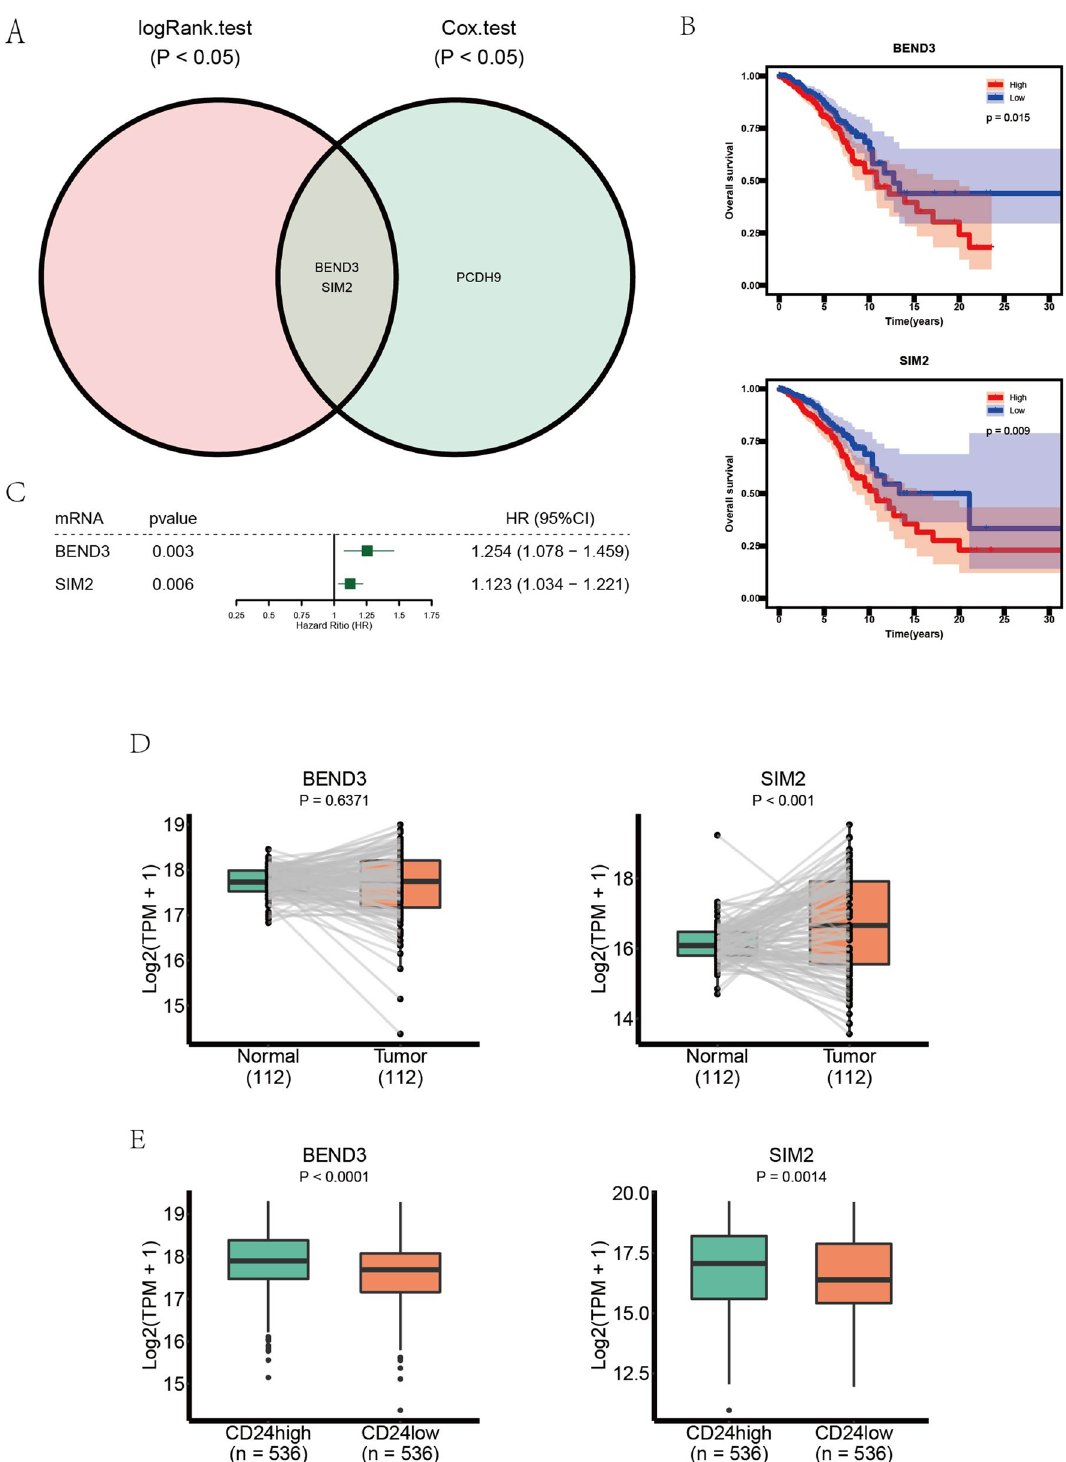
Figure 8. Comprehensive analysis of DEmRNAs. ( A ) Veen diagram of prognosis-related DEmRNAs in CD24- based ceRNA network. ( B ) Kaplan-Meier curve analysis of key DEmRNAs. ( C ) Univariate COX analysis of key DEmRNAs. ( D ) The expression levels of key DEmRNAs in tumor samples and paired adjacent normal samples. ( E ) The expression levels of key DEmRNAs in two groups: CD24high samples and CD24low